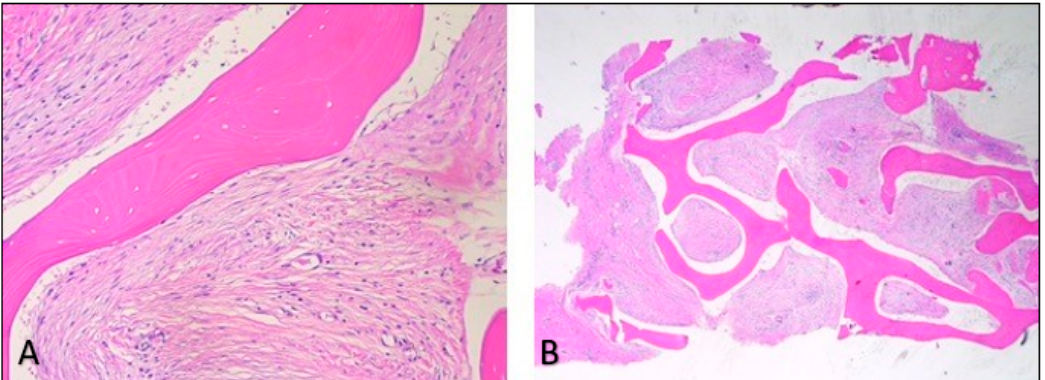
Figure 9. Histology (200 × ) segment: ( A , B ) show substitution of the SB ® , and the osteogenesis has Figure 9. Histology (200x) segment: ( A ) and ( B ) show substitution of the SB ® , and the osteogenesis Figure 9. Histology (200x) segment: ( A ) and ( B ) show substitution of the SB ® , and the osteogenesis formed a lamellar bone with cement lines; a lot of osteocytes inside the lacunae and a good angiogenesis has formed a lamellar bone with cement lines; a lot of osteocytes inside the lacunae and a good has formed a lamellar bone with cement lines; a lot of osteocytes inside the lacunae and a good has formed a lamellar bone with cement lines; a lot of osteocytes inside the lacunae and a good are angiogenesis are evidenced. angiogenesis are evidenced.